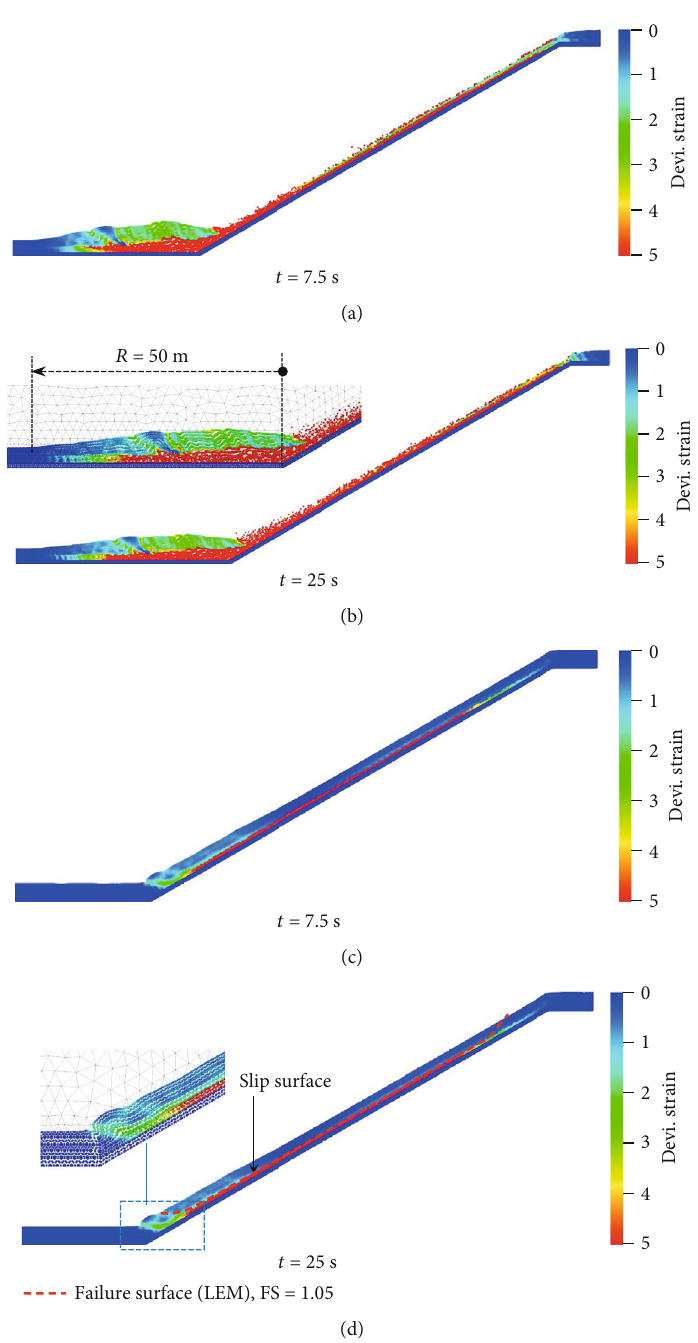
Figure 12: E ff ect of soil cohesion on the postfailure behavior of a slope: (a, b) c ′ = 0 kPa ; (c, d) c ′ = 7kPa